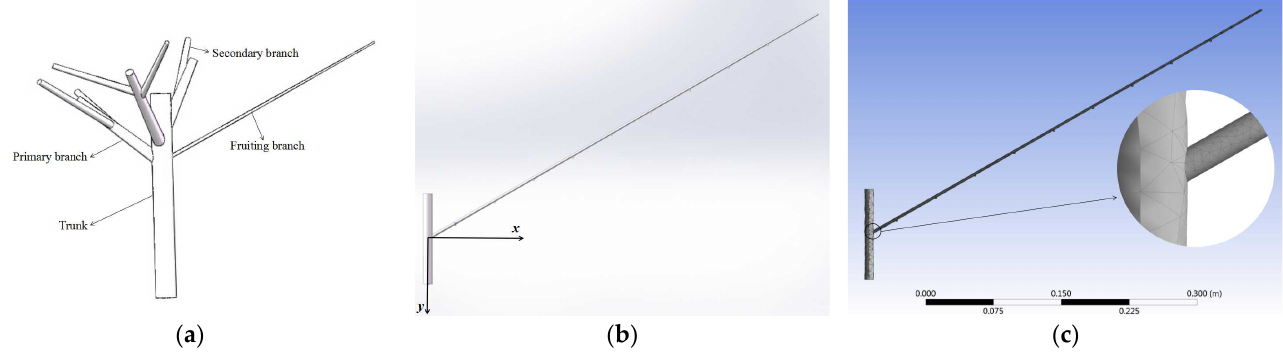
Figure 3. Three-dimensional model and finite element model of branches: ( a ) schematic diagram of wolfberry tree without gravity; ( b ) branch geometric model; ( c ) branch meshing and local mesh refinement.